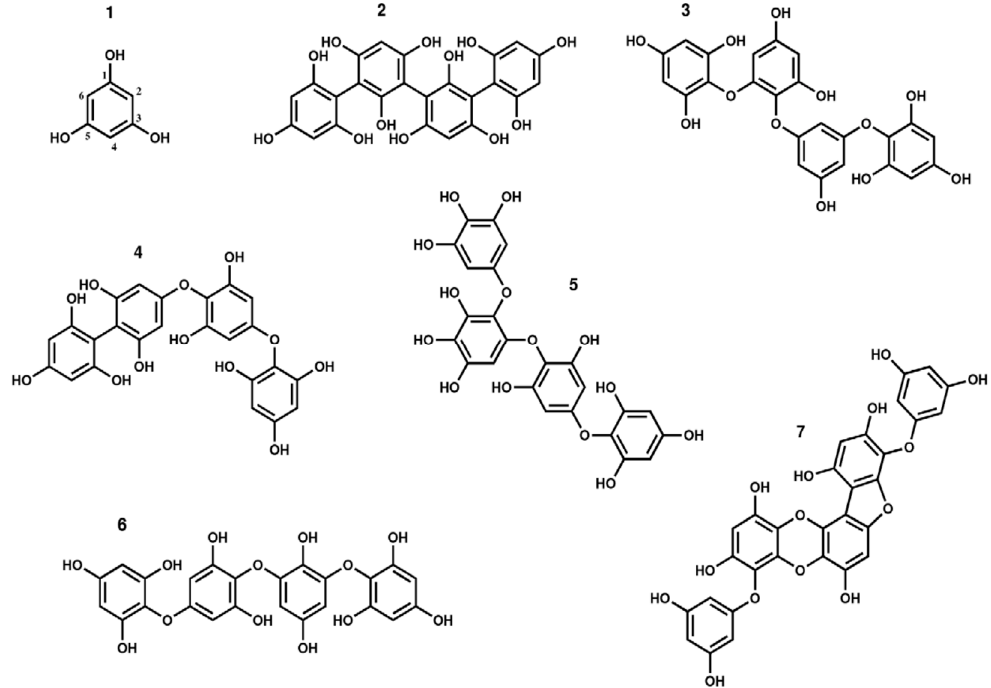
Figure 1. Chemical structures of different types of phlorotannins. Phloroglucinol ( 1 ), Tetrafucol A ( 2 ), Tetraphlorethol B ( 3 ), Fucodiphlorethol A ( 4 ), Tetrafuhalol A ( 5 ), Tetraisofuhalol ( 6 ), and Phlorofucofuroeckol ( 7 ).